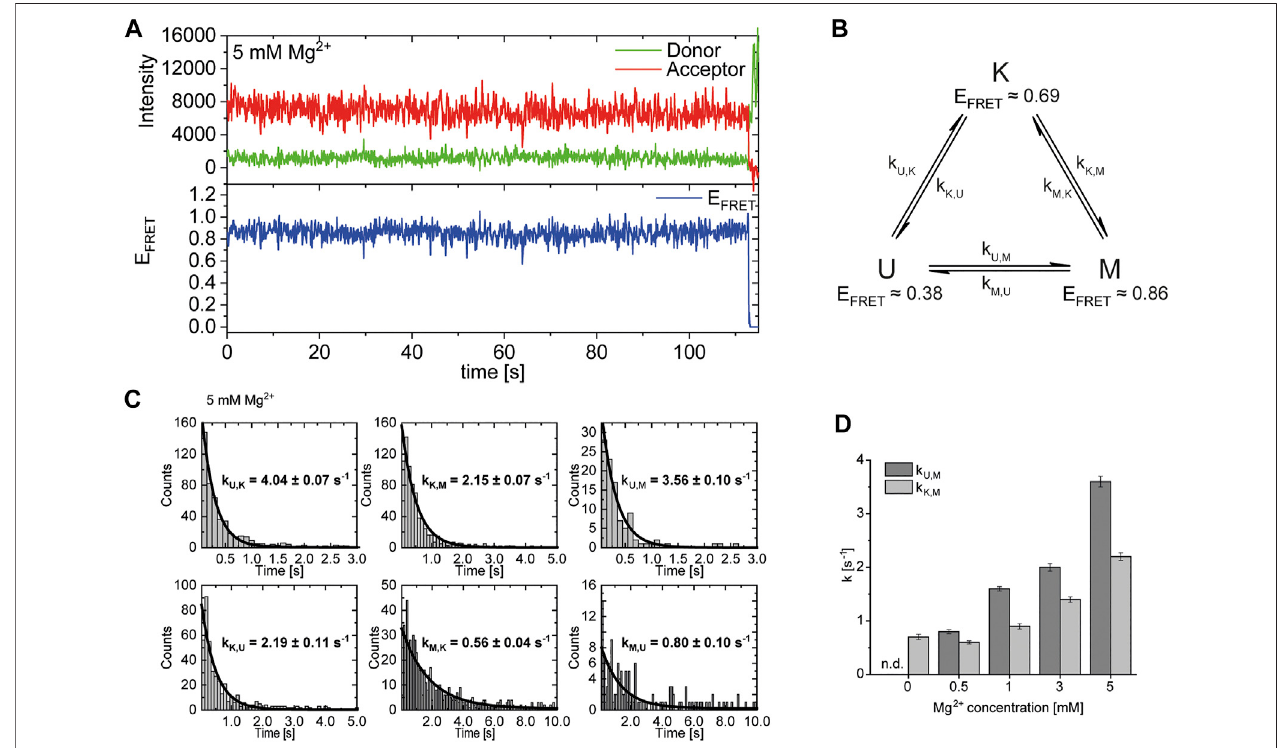
FIGURE 5 | (A) Example of a FRET trace of a static molecule in the M-state. (B) Three state kinetic model. (C) Examples of dwell time plots used to determine transition rates. smFRET trajectories for each condition were fi tted for three states with HaMMy and resulting dwell times were fi tted with a monoexponential decay. (D) Change of transition rates with increasing Mg 2+ concentration of the transitions of the U to M (dark grey) and K to M (light grey).